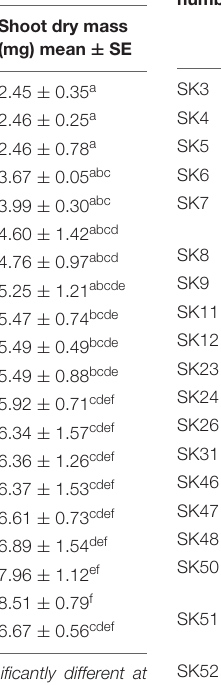
TABLE 2 | Best BLAST matches for DSE fungi based on SSU, ITS, and LSU regions. Isolates